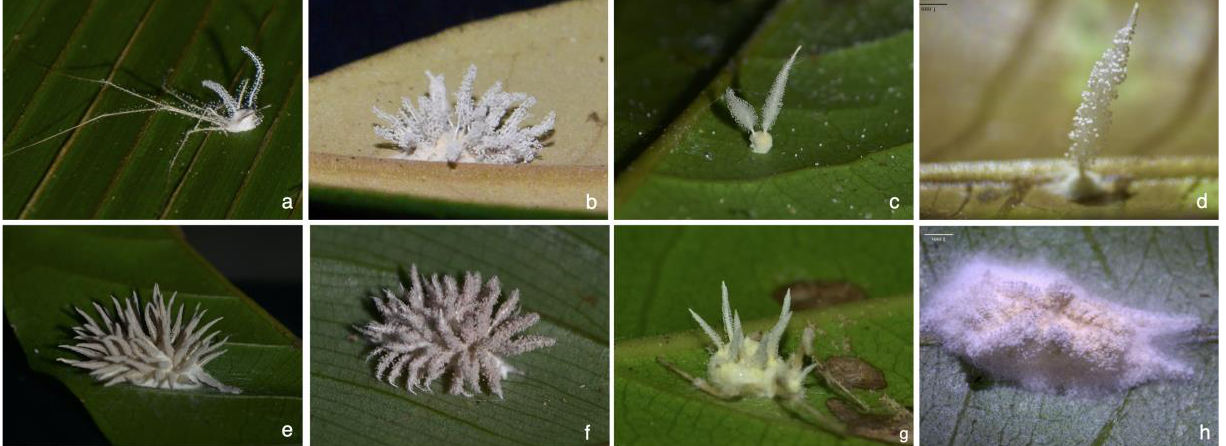
Figure 3. Representative species of Gibellula from the Brazilian Atlantic rainforests included in the molecular phylogeny of the genus. ( a , b ) Gibellula pulchra on spider ( a ) Pholcidae, ( b ) host not identified; ( c , d ) Gibellula mirabilis , hosts not identified; ( e – g ) Gibellula leiopus, hosts not identified; ( h ) Gibellula mainsii , host not